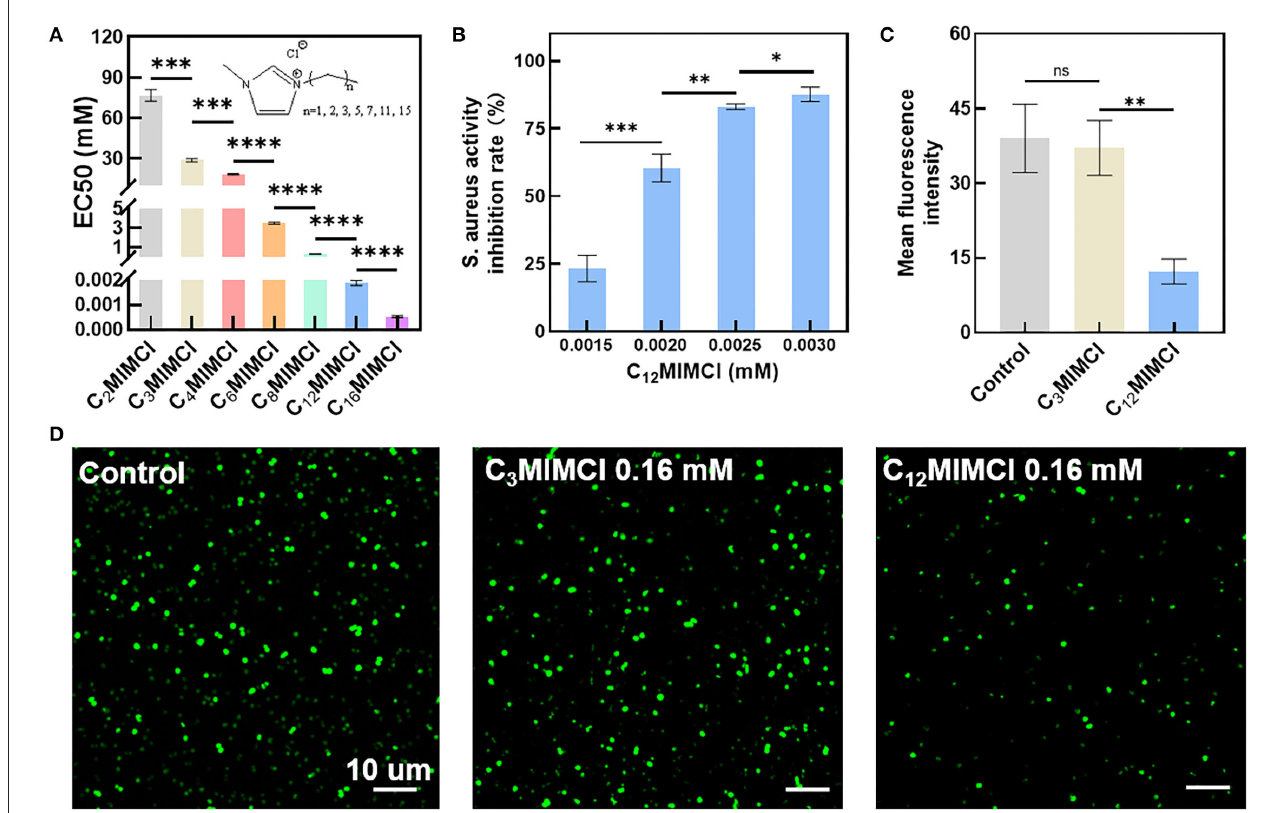
FIGURE1 Toxicity test of C n MIMCl against Staphylococcus aureus . (A) EC50 values of Staphylococcus aureus incubated with C n MIMCl for 24h. (B) Effects of C 12 MIMCl on Staphylococcus aureus at different concentrations. (C) Quantitative analysis of bacterial activity. (D) CLSM images of bacterial activity. Data in (A–C) represent the mean ± s.d. Statistical significance was calculated via two-tailed unpaired Student’s t -test (A–C) . Ns means no significant difference, * P < 0.05, ** P < 0.01, *** P < 0.001, **** P <